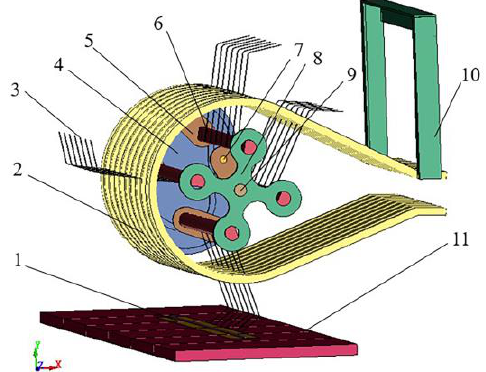
Figure 2. Schematic diagram of the pick-up system structure (1: sugarcane leaf; 2: guard plate; 3: elastic teeth; 4: cam plate; 5: crank linkage; 6: elastic teeth rod; 7: roller wheel; 8: roller plate; 9: power shaft; 10: door frame; 11: ground).